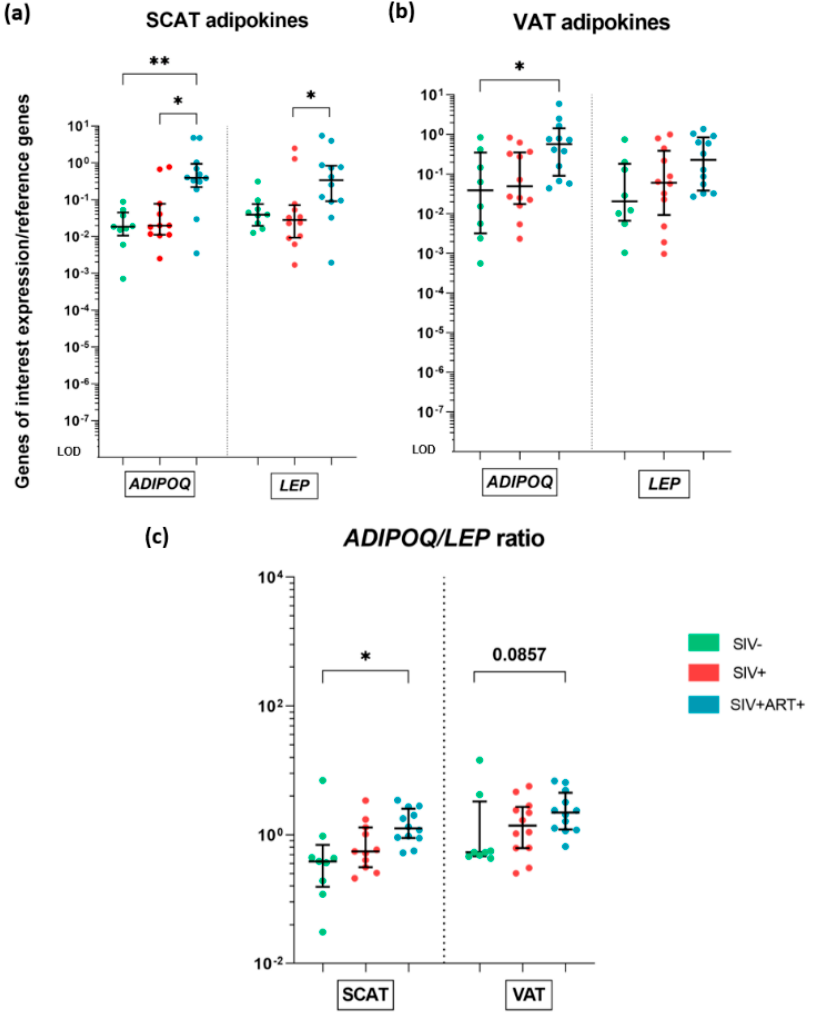
Figure 3. Whole-tissue gene expression analysis of adipokine production by the AT. RT-qPCR analysis of the mRNA expression of genes encoding adiponectin ( ADIPOQ ) and leptin ( LEP ) within the SCAT and VAT, in the three groups of animals: SIV − (green), SIV+ (red), and SIV+ART+ (blue). Expression of the genes of interest was compared with that of the 18S and PPIA housekeeping genes. The LOD was set to the difference vs. the mean level of housekeeping gene expression after 20 cycles, i.e., a 10 − − 8- fold difference. ( a , b ) mRNA expression of ADIPOQ and LEP in SCAT ( a ) and VAT ( b ) in the three groups. ( c ) The ADIPOQ/LEP ratio in the three groups and within the SCAT (left) and VAT (right). The results are quoted as the median [IQR]. Kruskal–Wallis tests associated with Dunn’s multiple comparison test or Mann–Whitney tests were used for unpaired and paired comparisons, respectively. Only significant results and trends are shown: * p < 0.05, ** p <